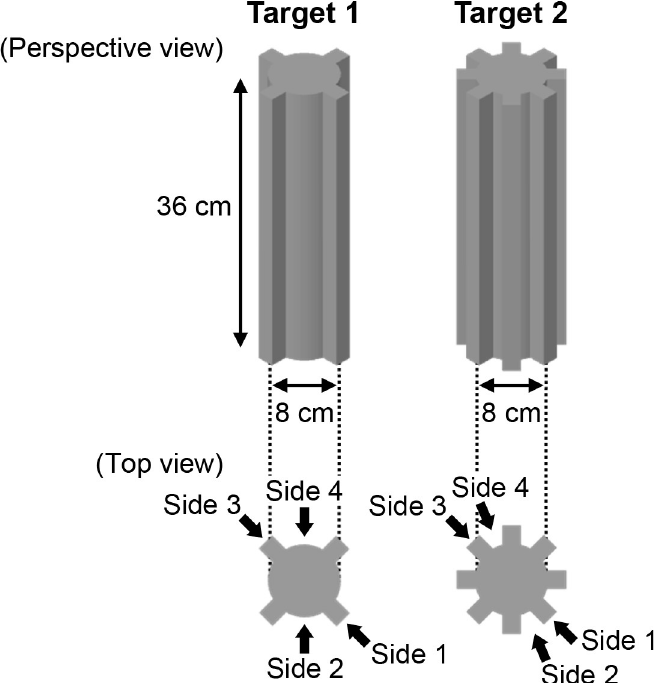
Fig 3. Targets. This figure shows the perspective (top) and top (bottom) views of targets 1 and 2 that were used in the experiment. Sides 1 to 4 of the targets were used to place the targets in the experiment (for details, see “Procedure” under the “Experiment”